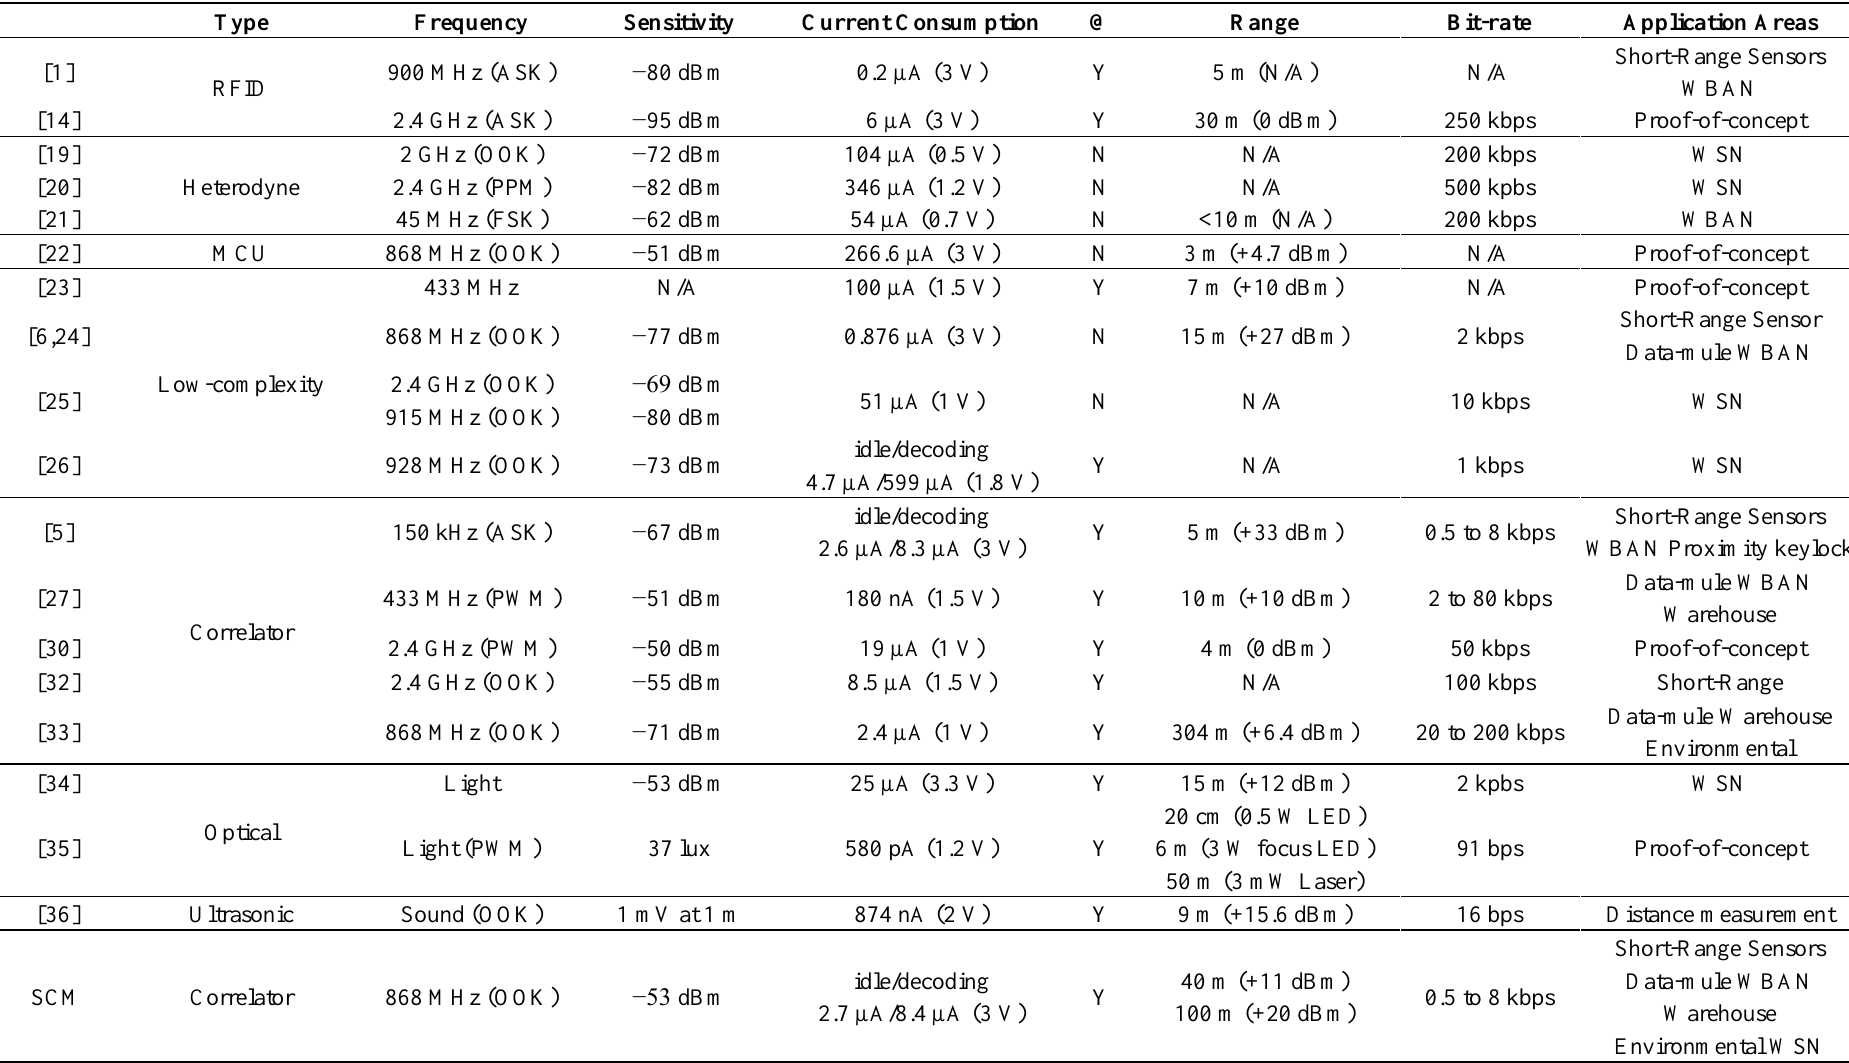
Table 3. Comparative of representative WuR proposals in